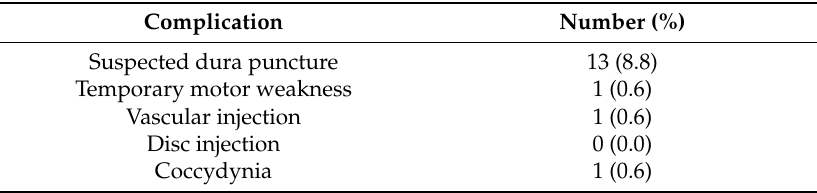
Table 6. Complications observed after combined epidural adhesiolysis and balloon decompression in patients with lumbar post-laminectomy